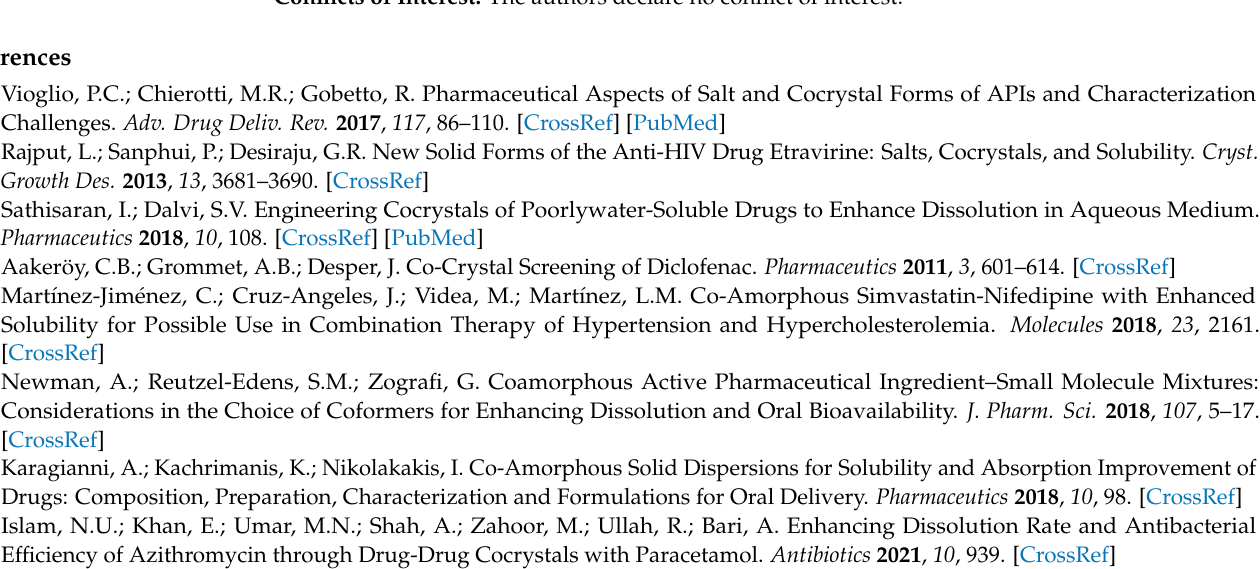
molar ratios; Figure S3. TG thermograms of cocrystal (LEV-PTH) and amorphous salt (LEV-CFA); Figure S4. 1H-NMR (400 MHz, in CDCl3) spectra of LEV-PTH, integrated protons (red in individual Chemdraw structures) showing their presence in 1:1 ratio are marked by arrows. NMR Chemical Shift values (s ppm, nJ(1H,1H) in Hz) = 15.18 br, 8.95 s, 7.56–7.53 d (12.3 Hz), 7.42–7.39 d (15.9